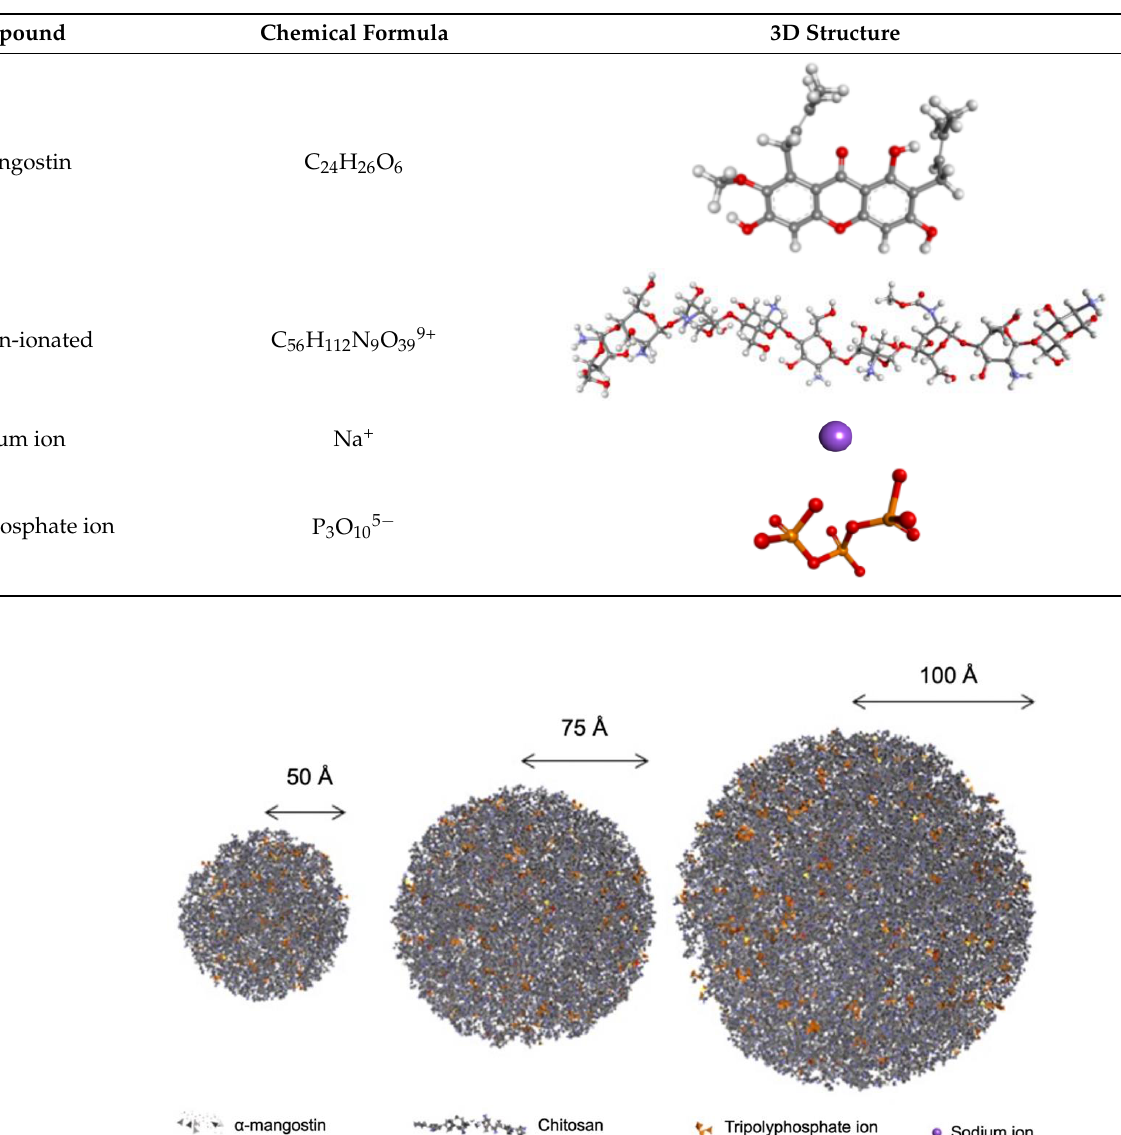
Table 2. Structural preparation results of α -mangostin, chitosan, and sodium tripolyphosphate.